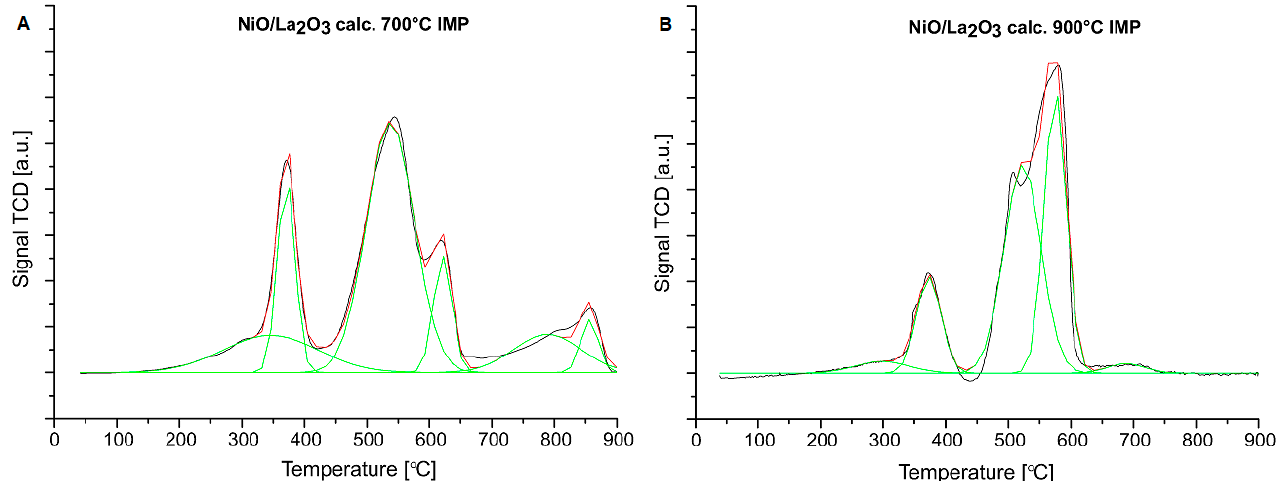
Figure 2. TPR-H 2 profiles of NiO/La 2 O 3 catalysts prepared by wet impregnation method and calcined at 700 °C ( A ) and 900 ( B ) °C in an air atmosphere for 4 h.